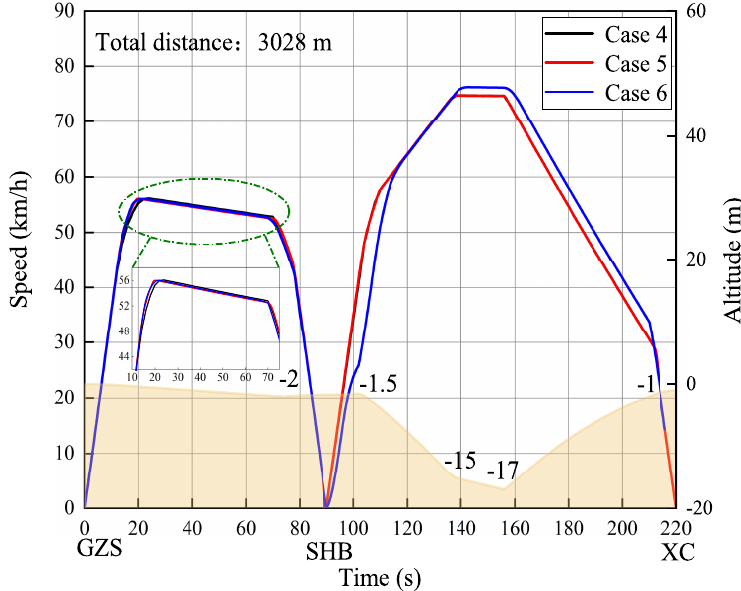
Figure 10. The optimal speed trajectories and altitude profile for cases 4–6.